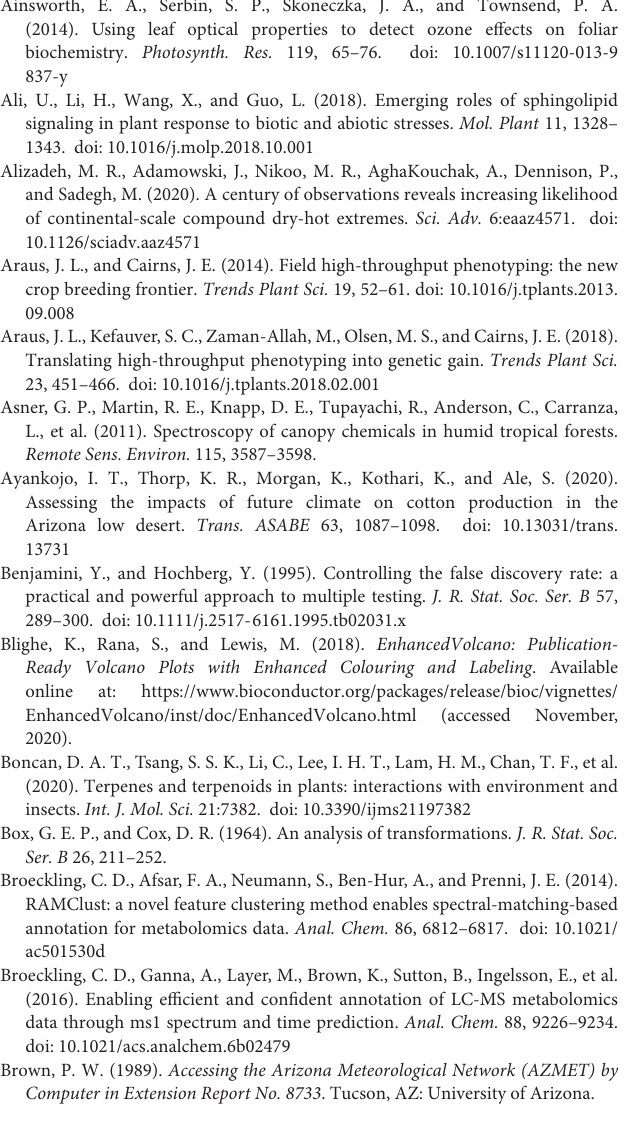
Supplementary Table 12 | List of the 69 metabolites accurately predicted by the “4-fold CV models” in 2019.